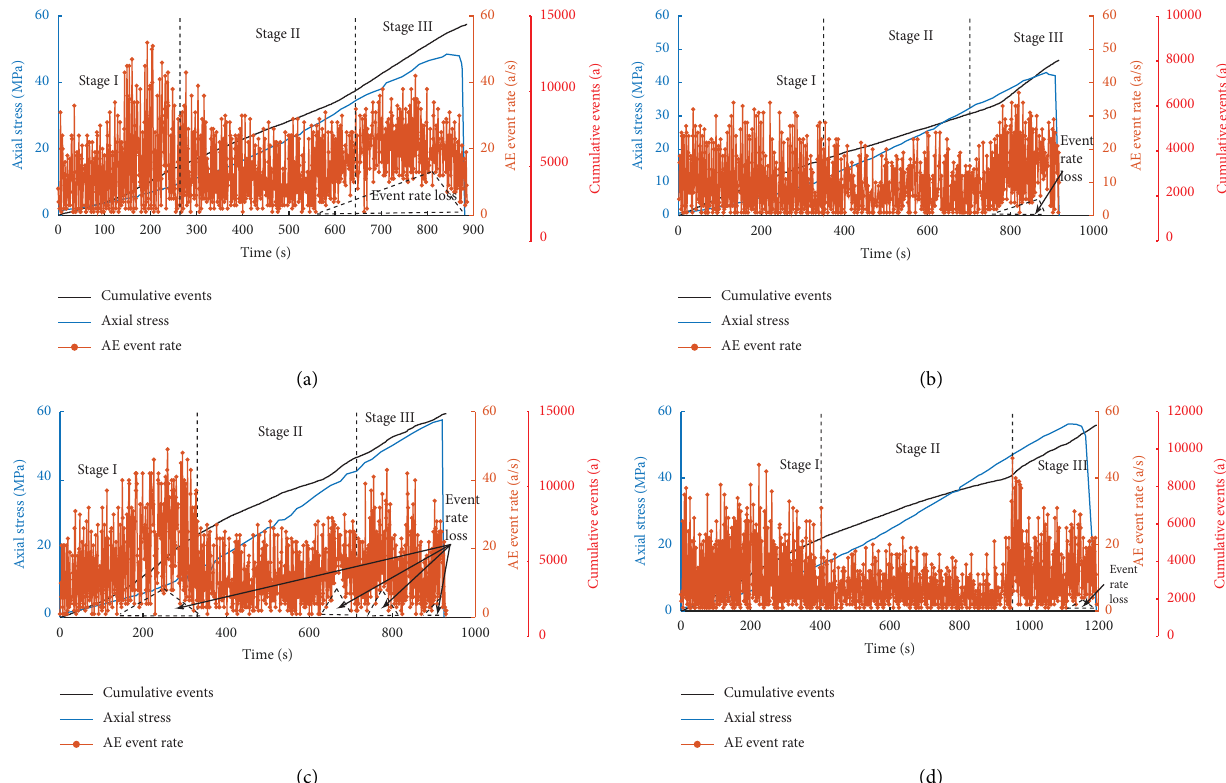
Figure 4: AE event rate-cumulative number of events-axial stress evolution over time. (a) QSY